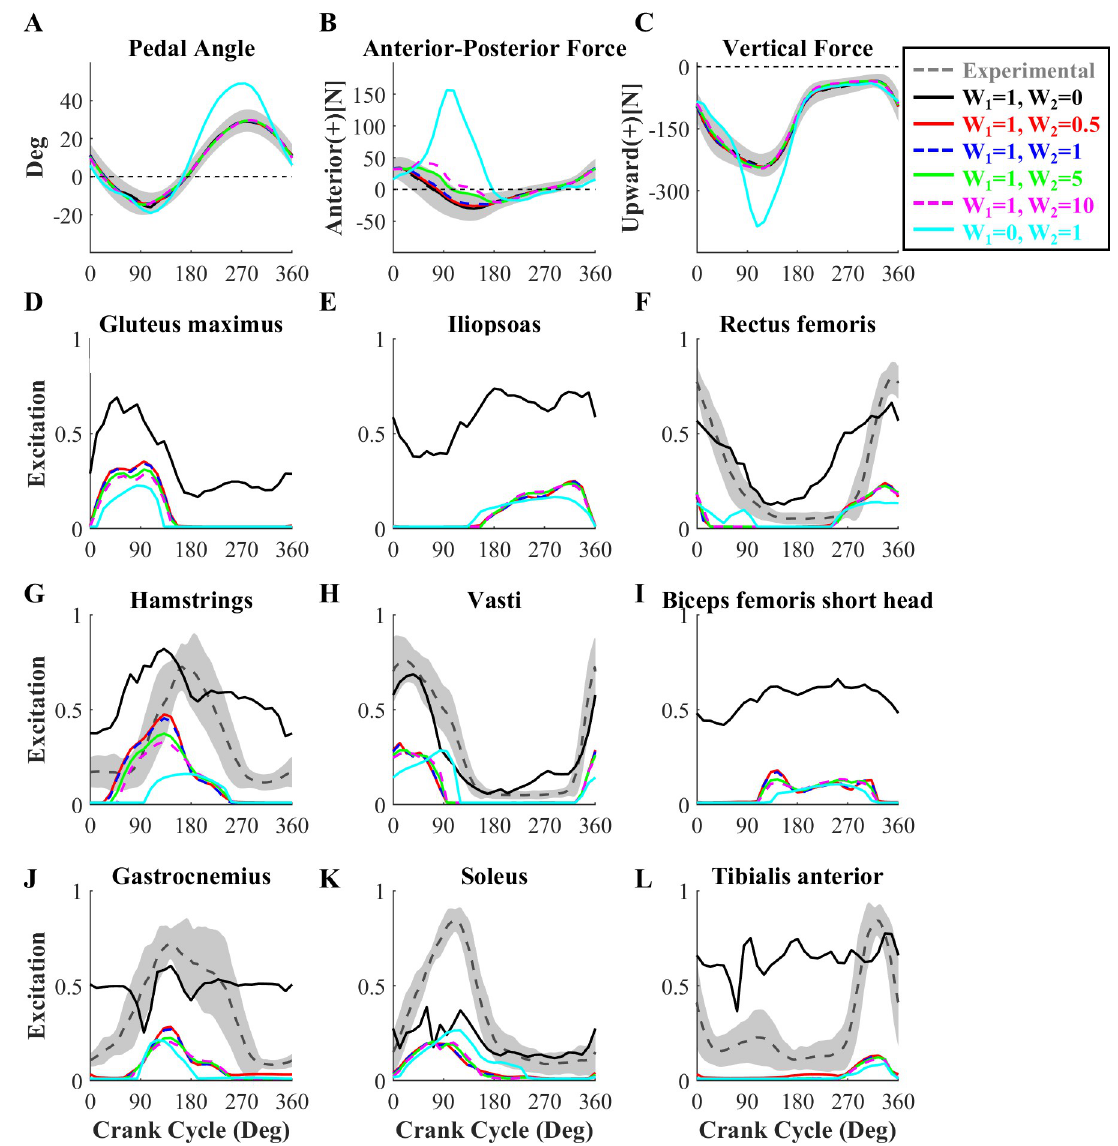
Fig 3. Simulated pedal angles, pedal forces, and MTU excitation patterns using different objective function term weightings. Simulated patterns of pedal angle (A), pedal forces (B and C), and MTU excitations (D-L) from simulations using the six combinations of objective term weightings compared with experimental data ( dark gray solid line , with gray shaded area representing ± 1 SD ). Because peak timings throughout the seven crank cycles were varied, the maximum values in the averaged experimental EMG patterns was below one. The tracking term weight was held at W 1 = 1, while the activation term weight (W 2 ) was set to 0 (TrackOnly, black solid line ), 0.5 ( red solid line ), 1 ( blue dotted line ), 5 ( green solid line ), and 10 ( magenta dotted line ). In ActOnly, the tracking term weight was W 1 = 0 and the activation term weight was W 2 = 1 ( cyan solid line ). Experimental EMG data for the gluteus maximus, iliopsoas, and biceps femoris short head were not available. Simulated data from the left leg are shown, those from the contralateral leg are almost identical. Either 0.5 or 1 weighting for the tracking term produced high tracking quality with physiologically realistic muscle activation